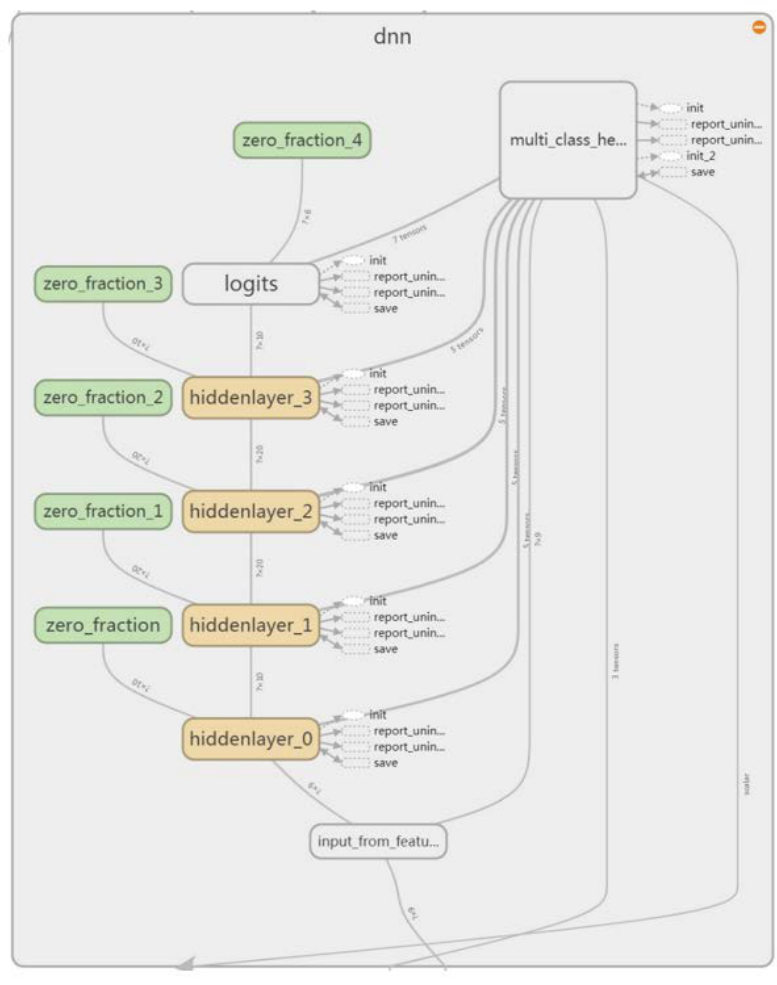
Figure 5. The expansion of the DNN layer.